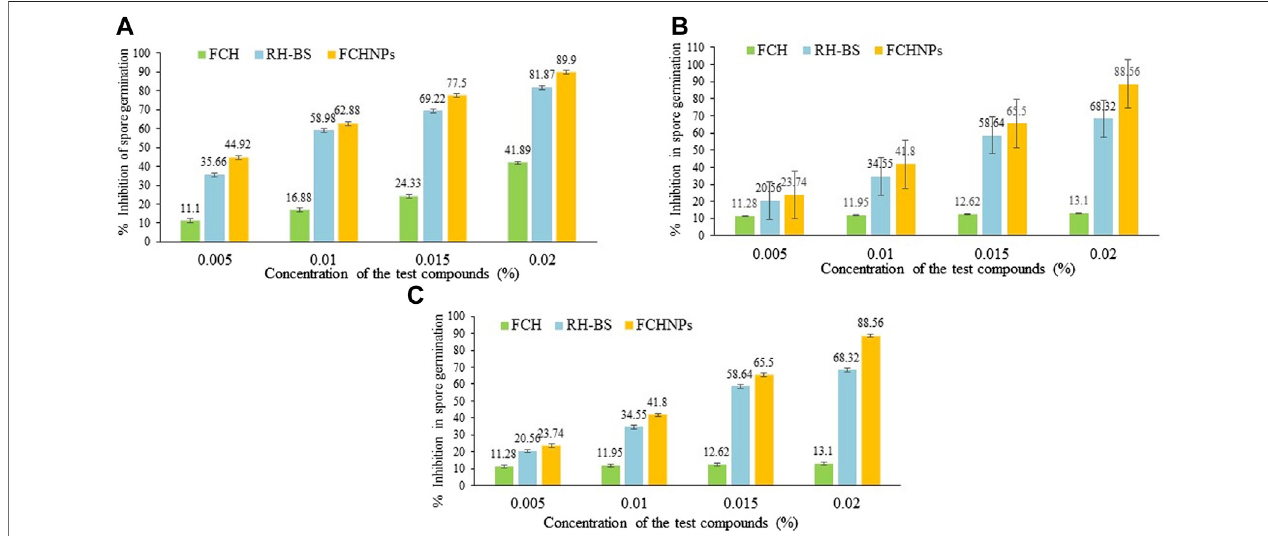
FIGURE 7 | Graphical representation of inhibition in spore germination via rhamnolipid biosurfactant (RH-BS), fungal chitosan (FCH), and synthesized chitosan nanoparticles (FCHNPs) of fungal phytopathogens. (A) FI: F. moniliforme Sheldon ITCC 191; (B) FII: F. moniliforme Sheldon ITCC 4432; and (C) FIII: F. graminearum Schwabe ITCC